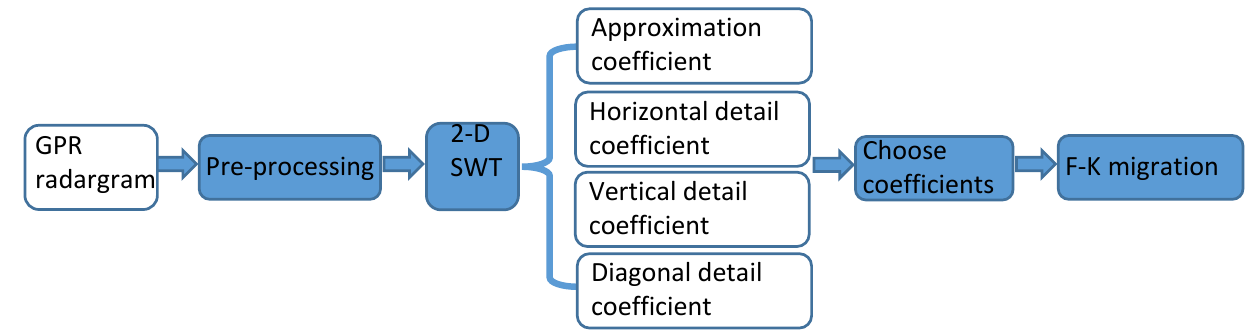
Figure 2. The flowchart of proposed